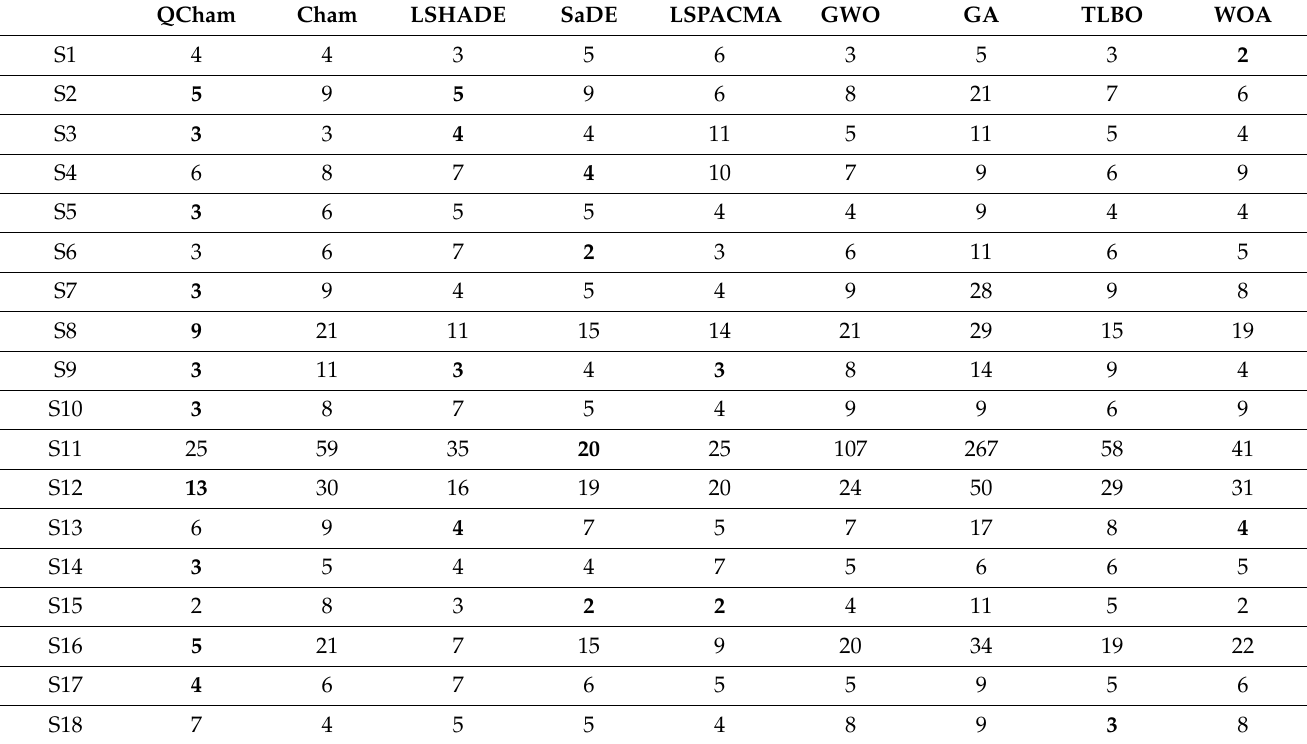
Table 6. Selected features numbers for all